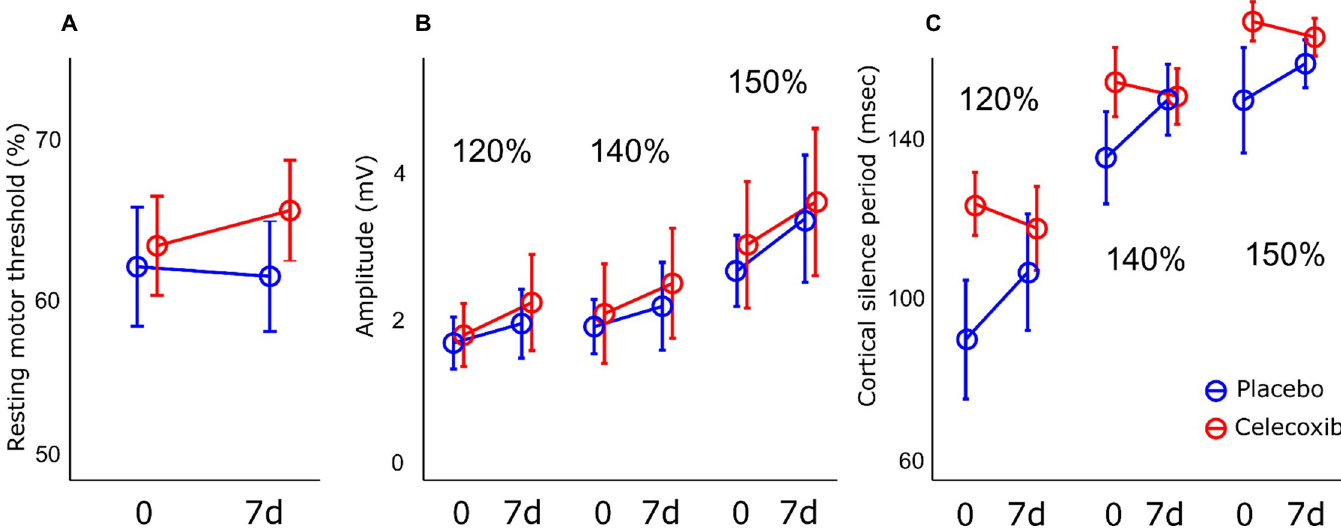
Fig 5. Transmagnetic stimulation parameters. No significant effects of 7-day treatment with celecoxib were found on the (A) resting motor threshold, (B) peak-to-peak amplitude, or (C) cortical silence period.